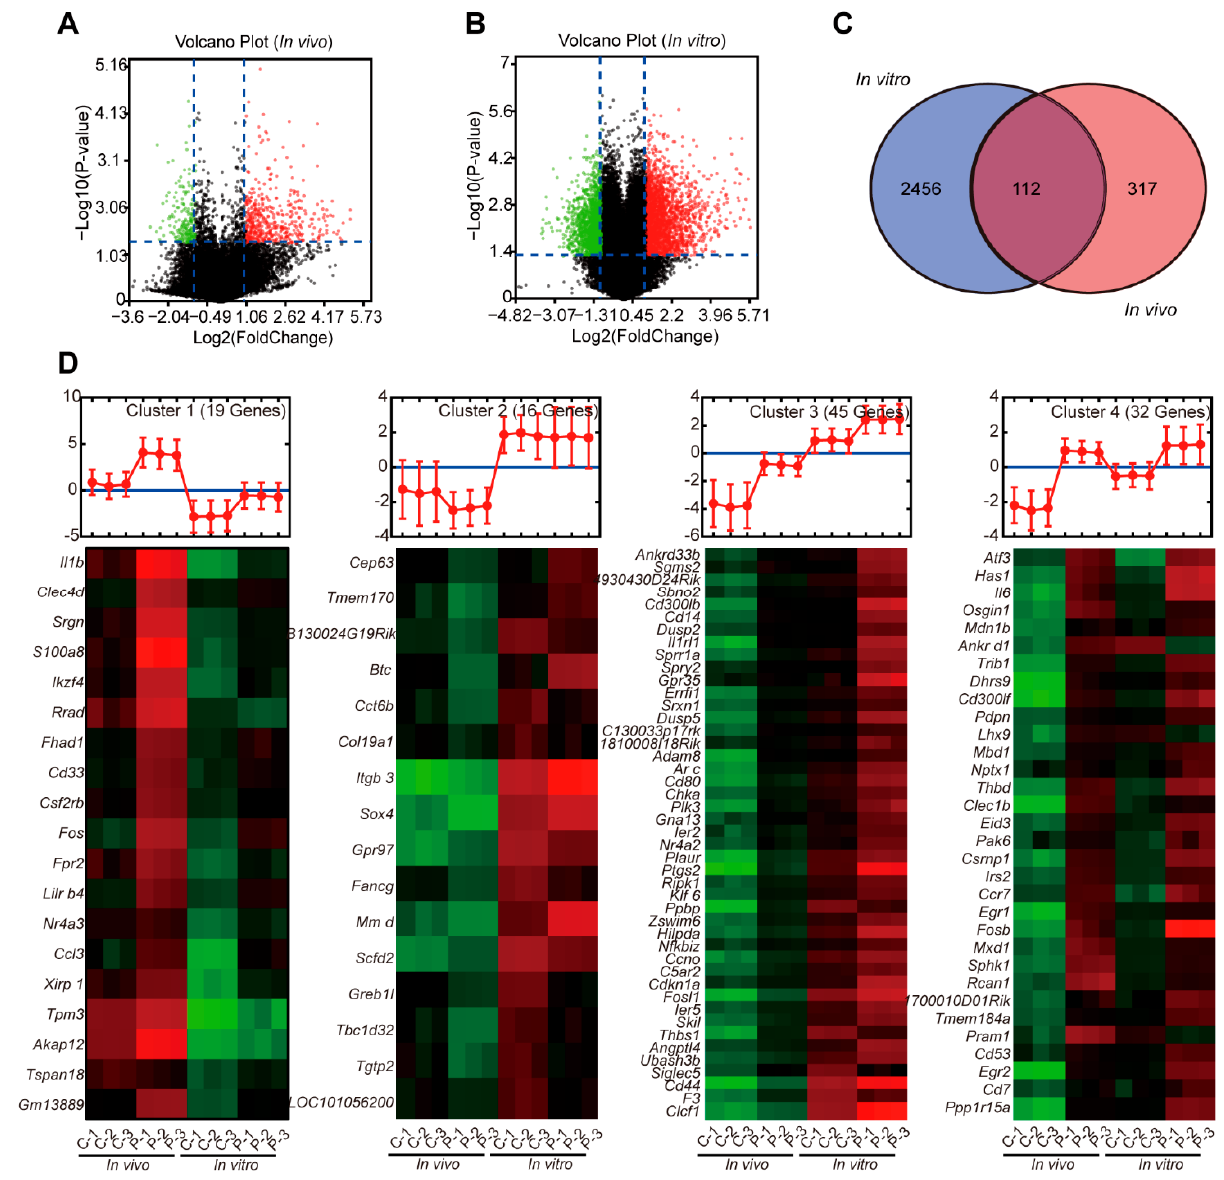
Figure 3. PD induced similar gene expression profiles in C2C12 cells and mouse quadricep muscles. C2C12 cells were stimulated with or without PD at 25 μ M. Mice were i.m. injected with 50 μ g PD at the quadricep muscles. The cells (for 4 h) and muscle tissues (2 h) were well collected and subjected to microarray analysis. ( A , B ) Volcano plots of gene expression in C2C12 cells ( A ) and quadricep muscles ( B ). ( C ) The Venn diagram showed the distribution of DEGs in PD-treated C2C12 cells and quadricep muscles. ( D ) Expression pattern analysis of 112 coregulated DEGs by k -means clustering with MultiExperiment Viewer.